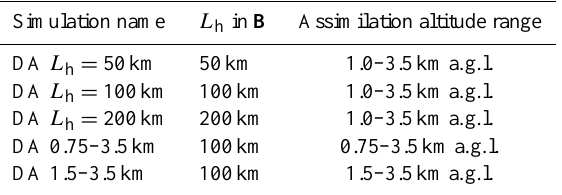
Table 2. DA tests with different configurations for the evaluation of the impact of the assimilation parameters on the forecasts. L h is the horizontal correlation length used in the Balgovind approach (Balgovind et al., 1983) to define the error covariance matrix B